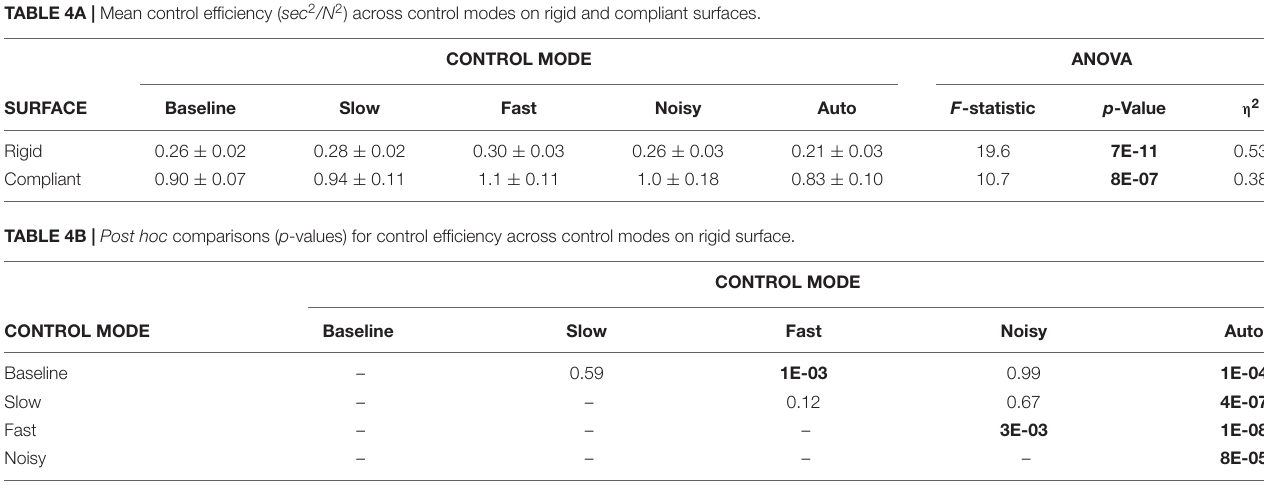
TABLE 4C | Post hoc comparisons ( p -values) for control efficiency across control modes on compliant surface.